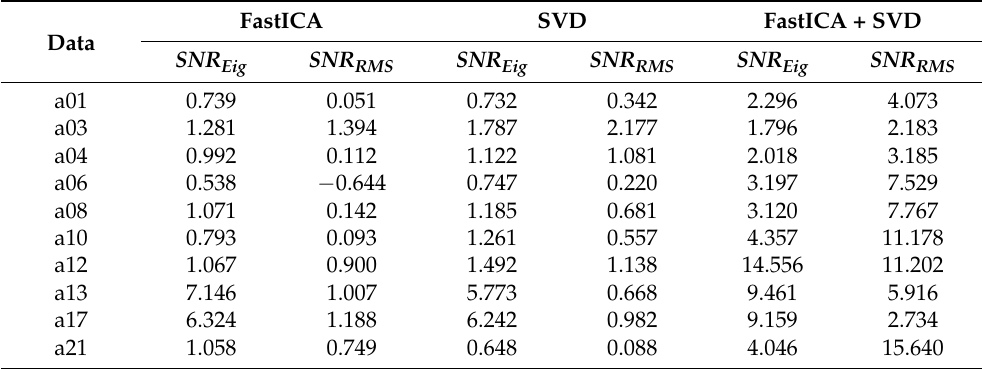
Figure 5. A total of 7000 sampling points of R10 data in the ADFECGDB database were applied to the extraction algorithm: ( a ) The second channel of maternal abdominal mixed signals in R10 data; ( b ) FECG signals estimated by the SVD algorithm; ( c ) MECG signals extracted by the FastICA algorithm; and ( d ) FECG signals extracted by the proposed algorithm. Table 2. Performance comparison of FECG signal extraction algorithms using the PhysioNet2013 database.